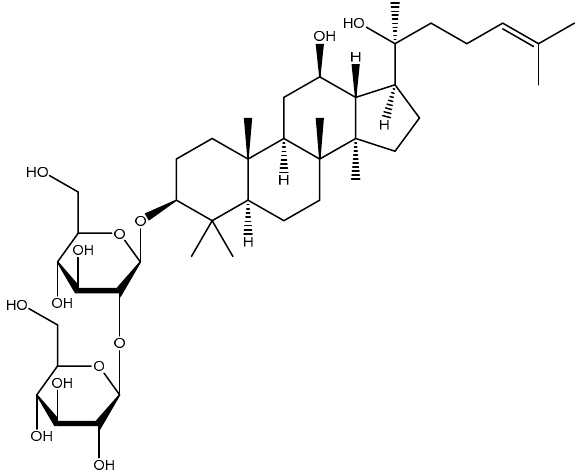
Figure 5. Chemical structure of ginsenoside Rg3.